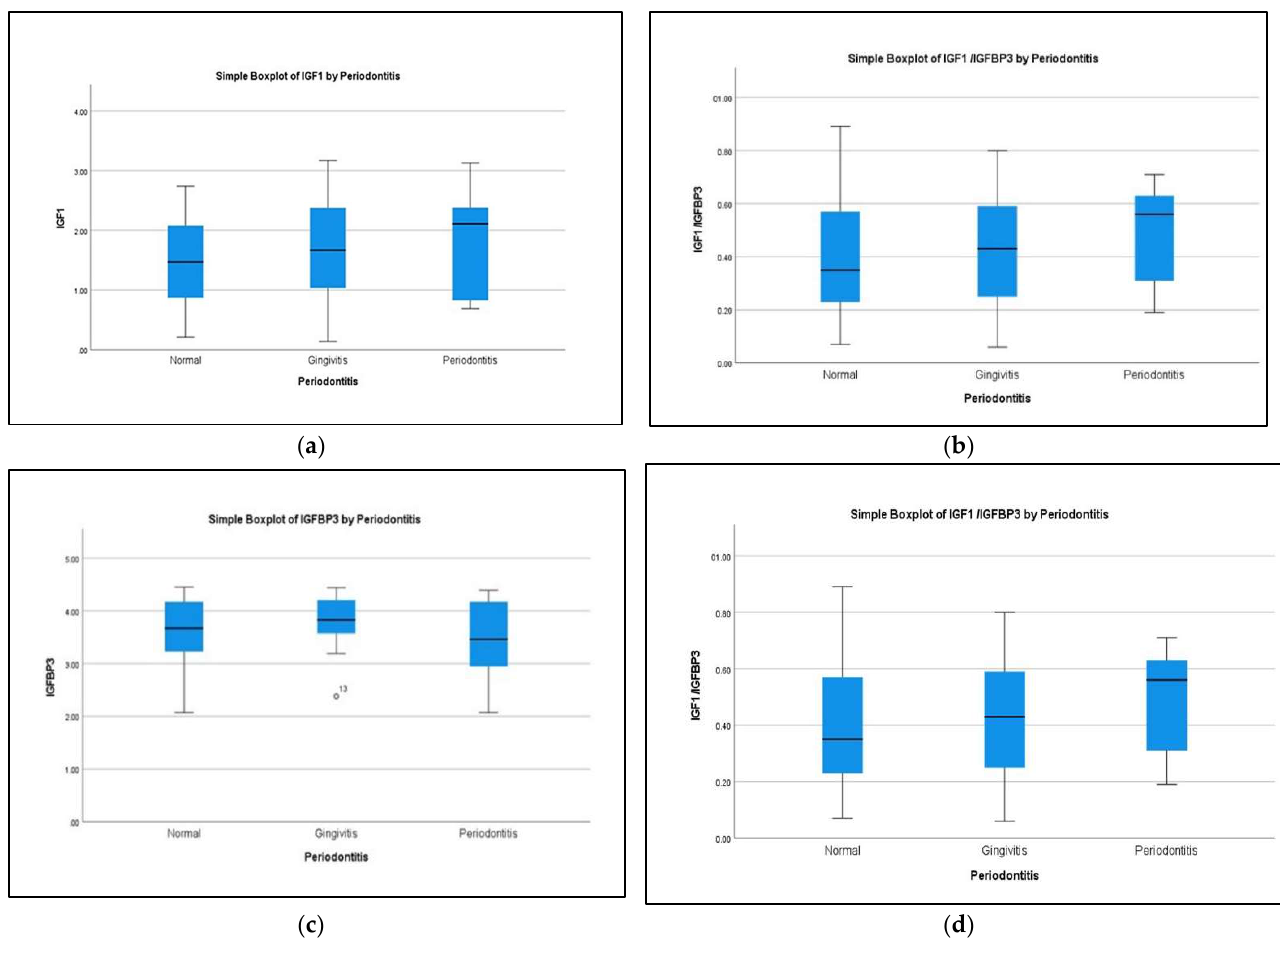
Figure 2. Comparison of the biochemical parameters between healthy participants and those with periodontal disease: ( a ) IGF-1, ( b ) IGFBP-3, ( c ) IGF-1/IGFBP-3, and ( d ) CTX1.